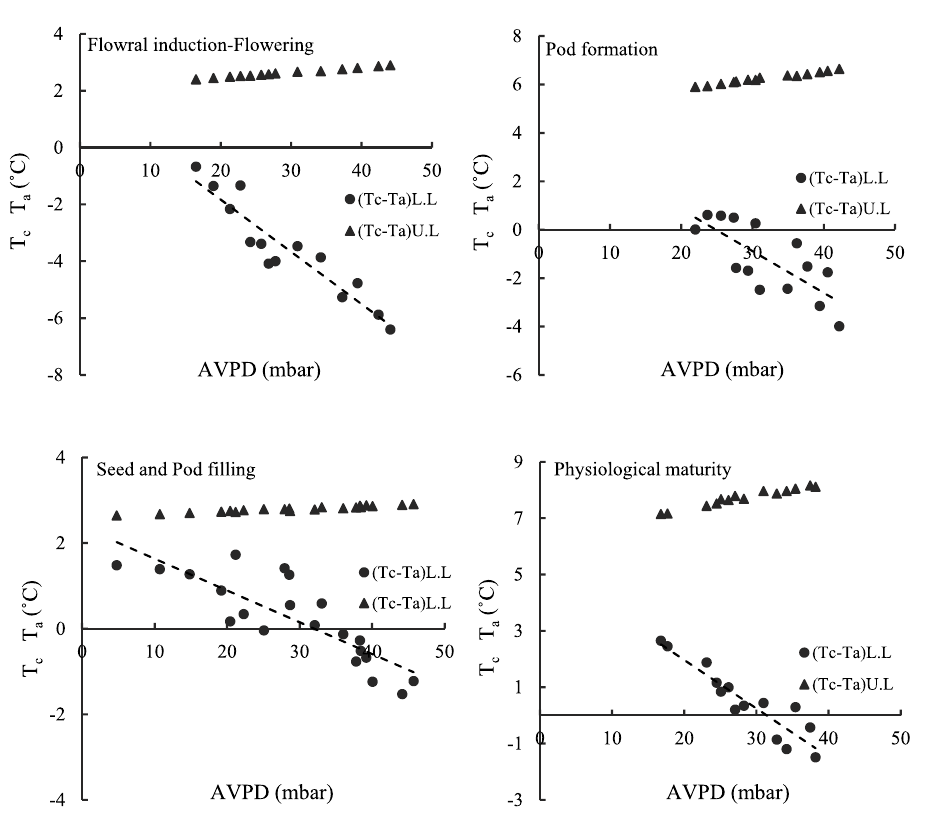
Figure 2. Lower and upper baselines for four stages of black gram